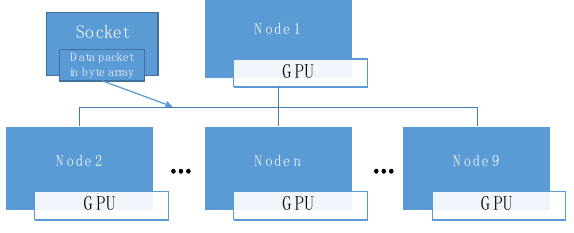
Fig. 4. Communication model of GPU clusters.